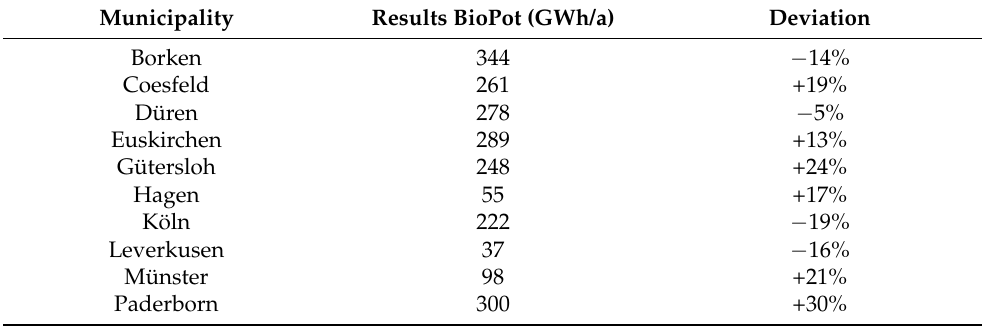
Table 4. Validation for bioenergy potential assessment in BioPot. Reference results provided by [21].